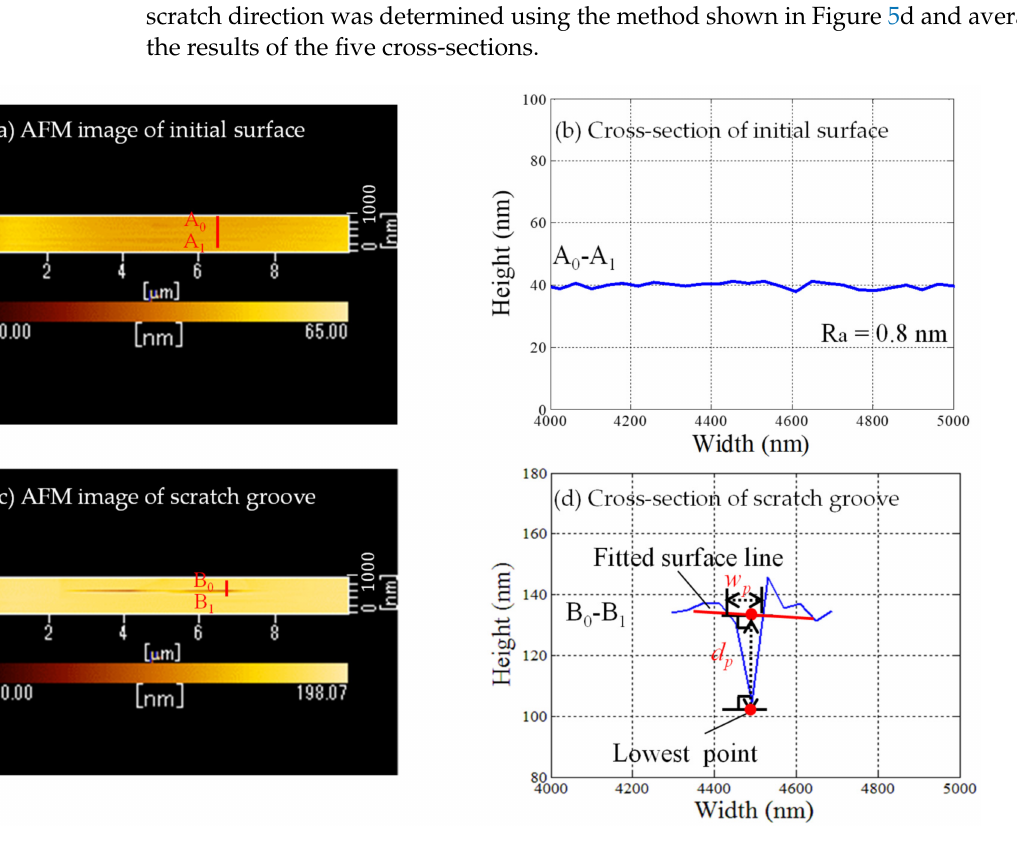
Figure 5. AFM images and cross-sections of initial surface ( a , b ) and scratch groove ( c , d ),